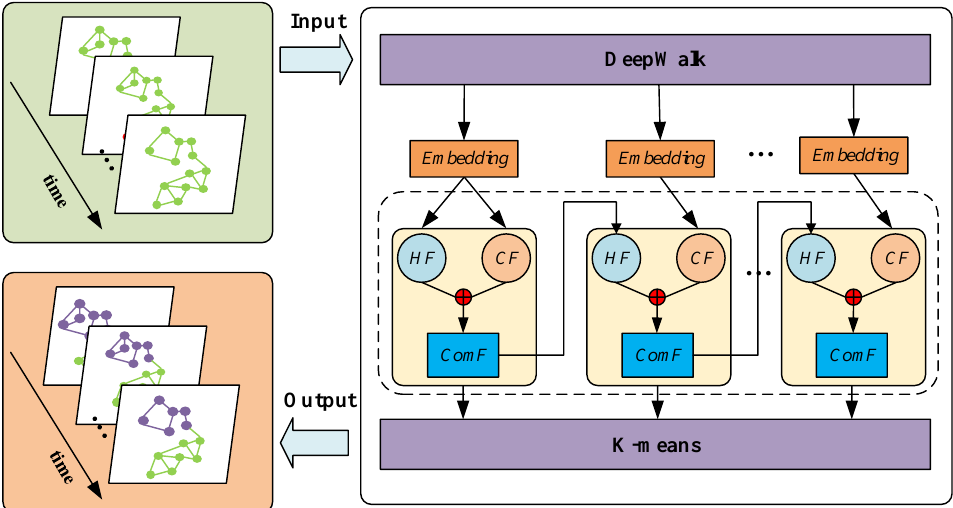
Figure 1. The research framework of this article.